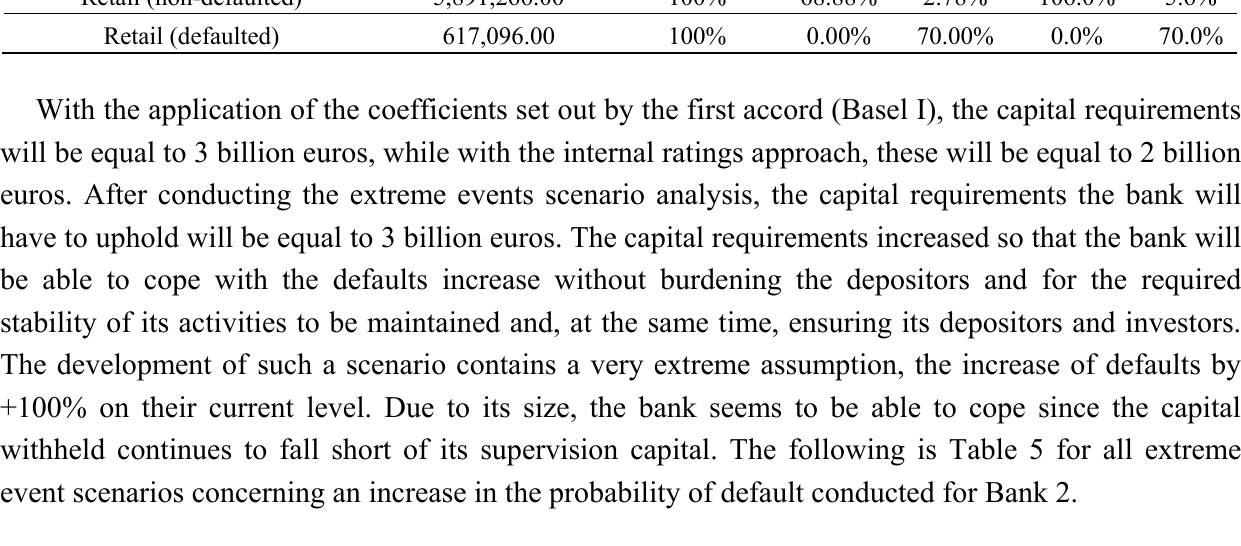
Table 5. Bank 2: stress scenarios for different levels of PD increases (th.